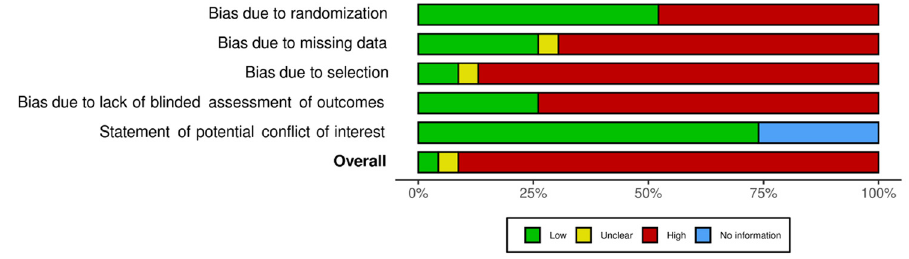
Fig. 3. Risk of bias summary for the included studies using the Cochrane Risk of Bias